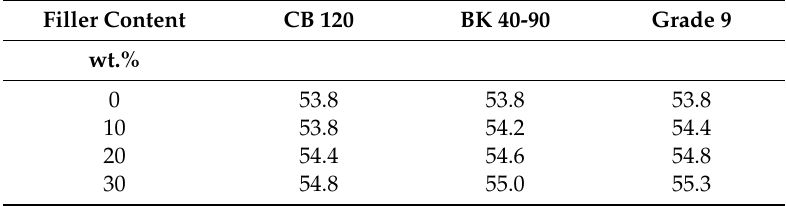
Table 5. HDT values ( ◦ C) of di ff erent samples with wood